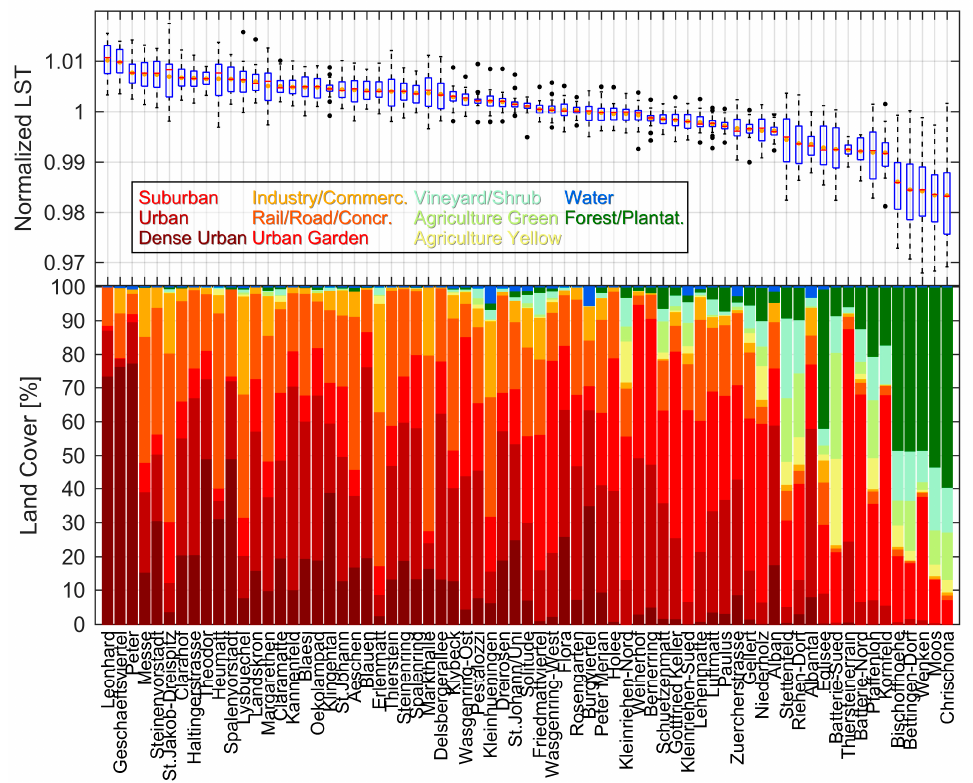
Figure 6. Boxplot of normalized LST averages [K/K mean ] of every individual residential district considering 32 scenes (above) compared to the individual LULC distribution of the respective district. The districts are ordered after the descending mean value of the normalized LST, the mean and median value are shown as orange dots and red lines, respectively.